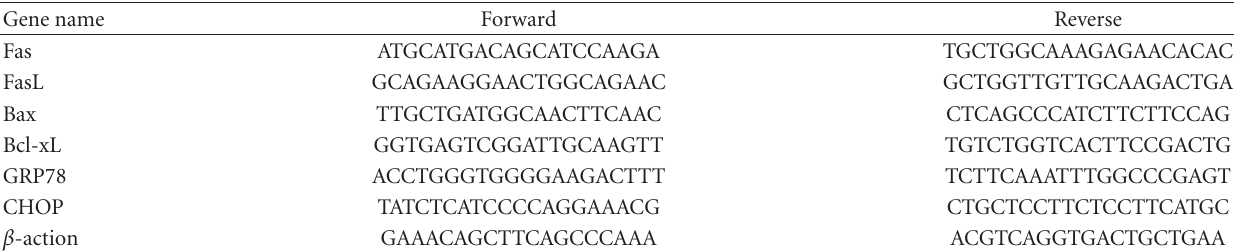
Table 2: Sequences of